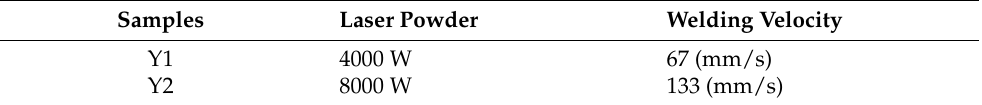
Table 1. Laser welding parameters.